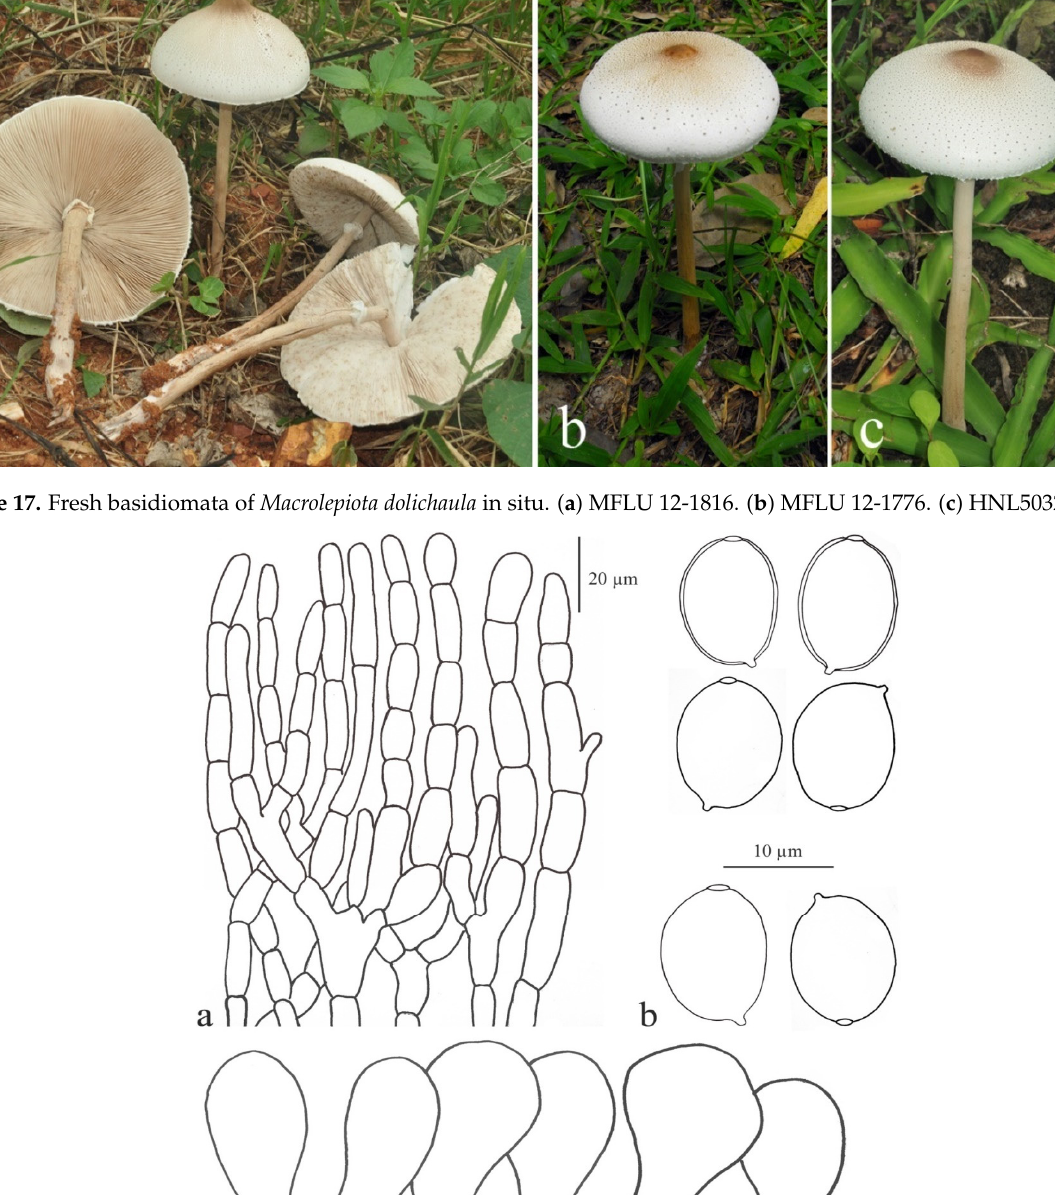
Figure 18. Microcharacters of Macrolepiota dolichaula (MFLU 12-1816). ( a ) pileus covering. ( b ) basid- iospores. ( c ) cheilocystidia. Pileus 75–175 mm, first subglobose to globose, soon expanding to campanulate, um- bonate with high umbo, with inflexed margin, with brownish-orange to light-brown (6C5–6, 6D6–7) glabrous surface and smooth when young, soon surface radially broken